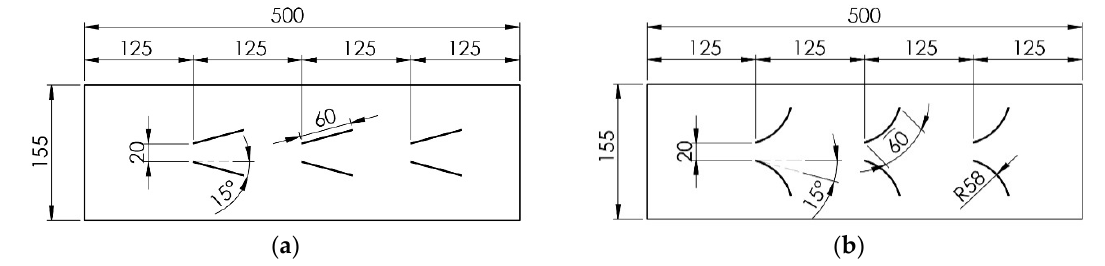
Figure 2. Detailed geometry of the concave rectangular winglet (CRW) and rectangular winglet (RW) vortex generators (VGs).